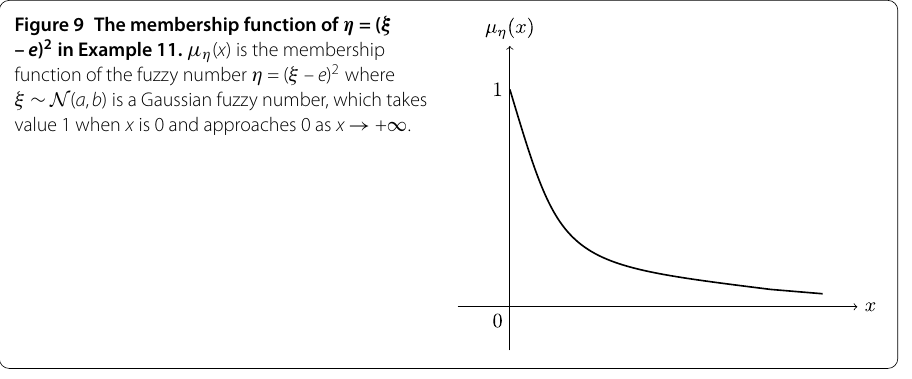
Figure 9 The membership function of η = ( ξ – e ) 2 in Example 11. μ η ( x ) is the membership function of the fuzzy number η = ( ξ – e ) 2 where ξ ∼ N ( a , b ) is a Gaussian fuzzy number, which takes value 1 when x is 0 and approaches 0 as x → + ∞